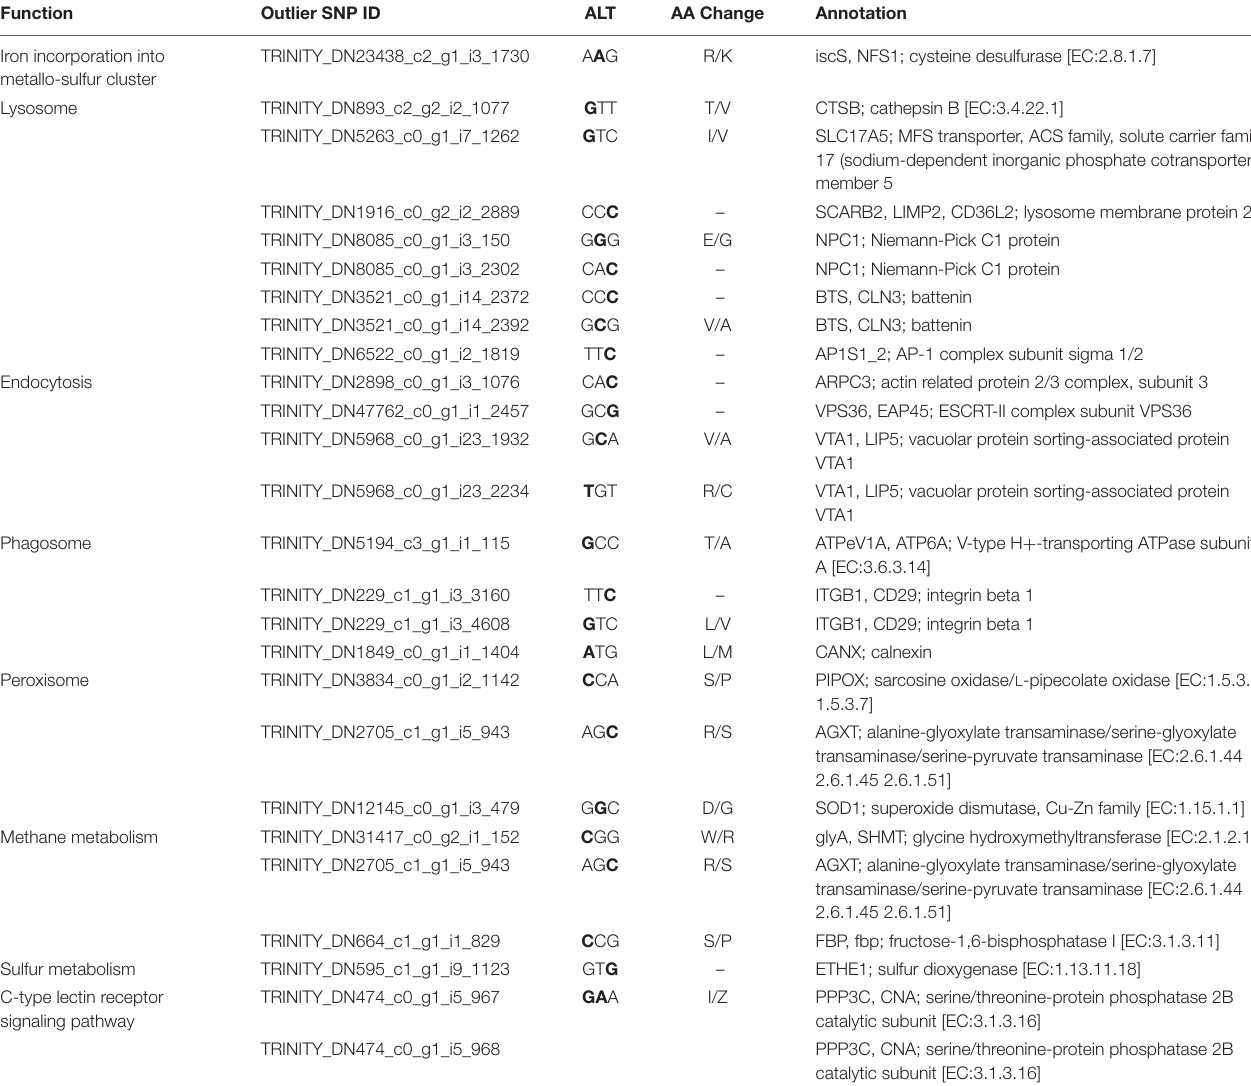
TABLE 5 | Functional classification and amino acid substitution of the 27 annotated outlier SNPs.